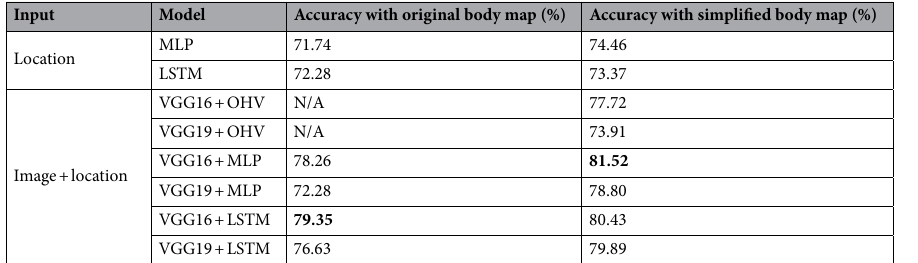
Table 4. Four wound class classification (D vs. P vs. S vs. V) on AZH dataset with simplified body map. The bold represents the highest results/accuracy achieved for each